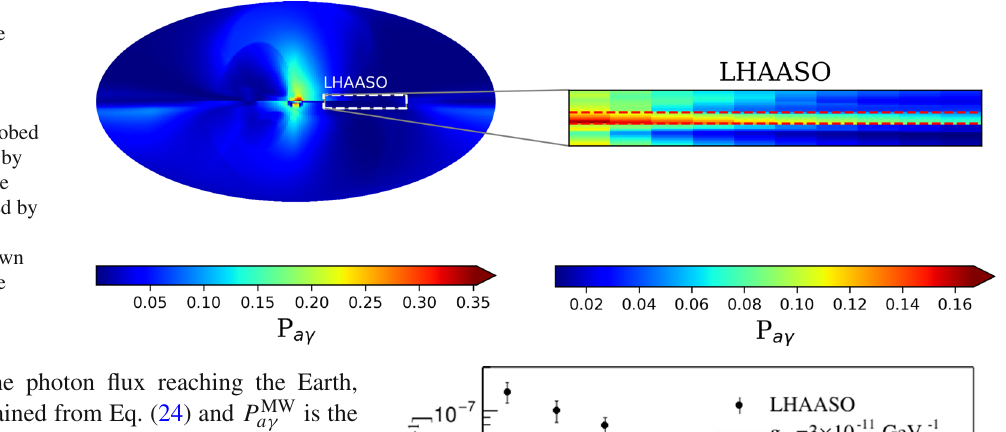
Fig. 8 Skymap of the conversion probability in the Galaxy for g a γ = 3 × 10 − 11 GeV − 1 , m a (cid:14) 10 − 7 eV and E = 10 TeV. The regions probed by LHAASO is highlighted by the white dashed line and the region approximately defined by b ∈ [− 1 ◦ , 1 ◦ ] is masked to avoid contamination by known sources in the Galactic plane